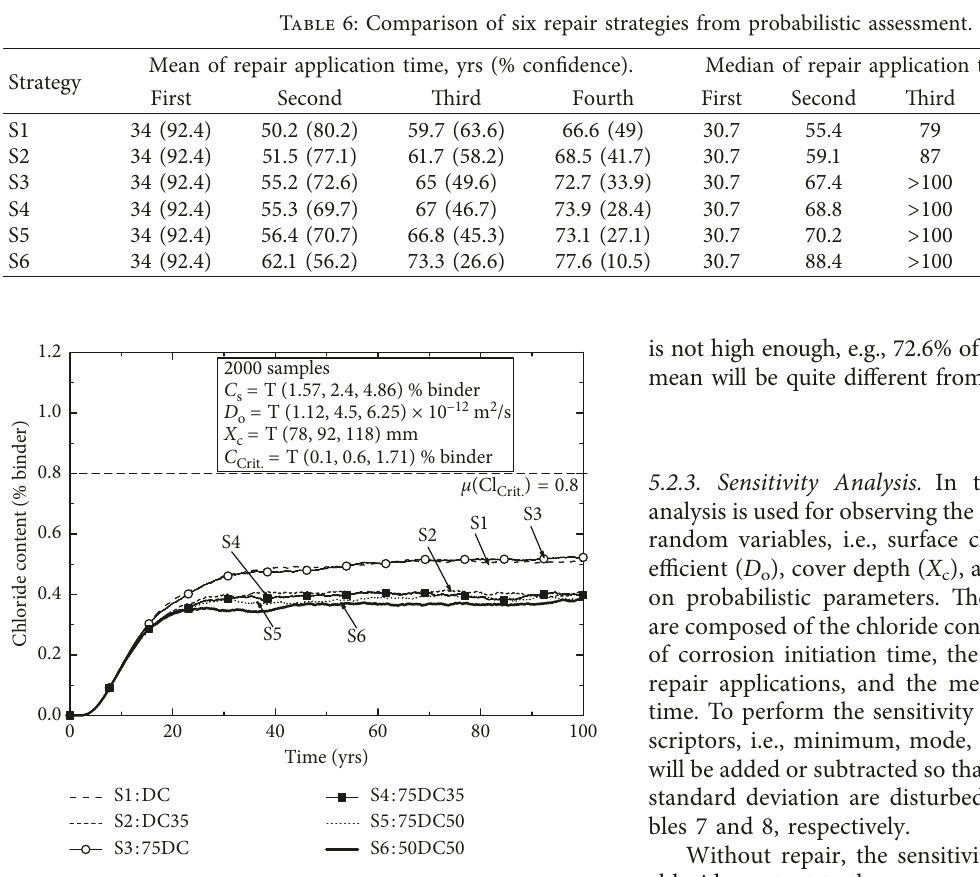
Figure 10: Mean profiles of chloride content with six proposed repair